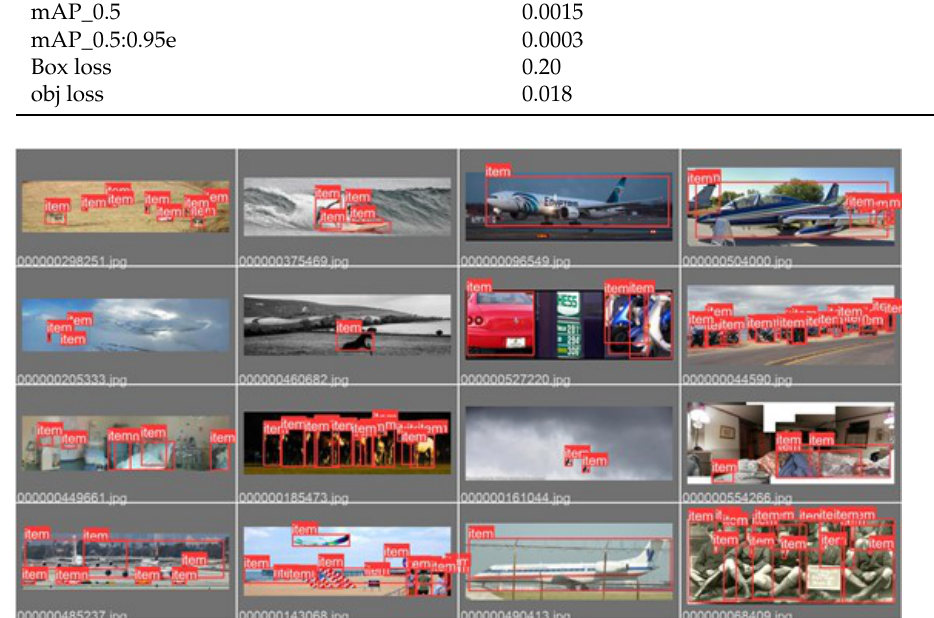
Figure 9. Examples of annotated images in the test set from the COCO and SEAGULL combination— ground truth bounding boxes visible.